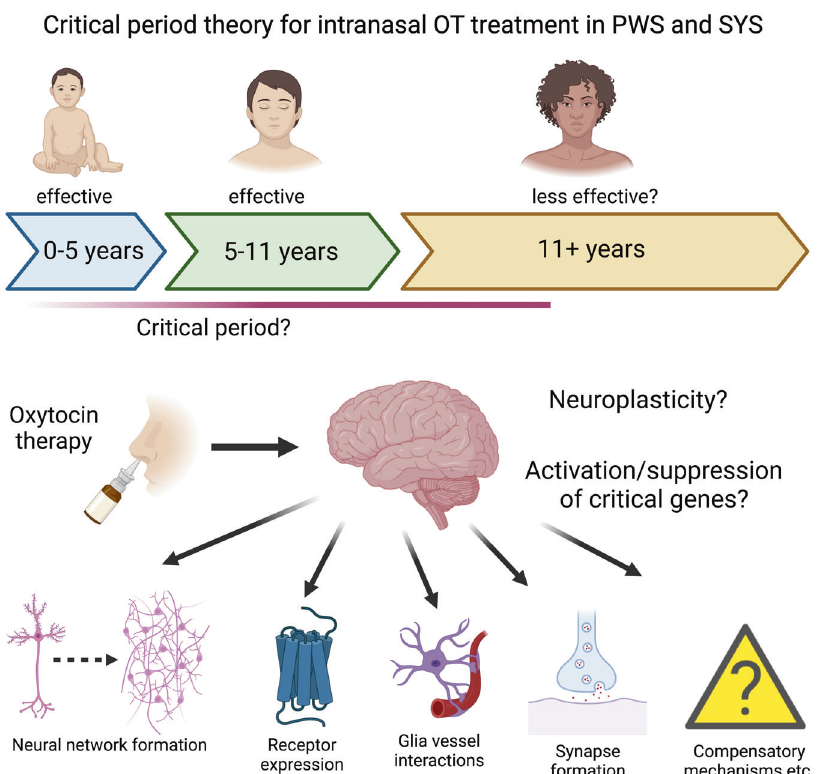
Fig. 4 Critical period theory for intranasal OT treatment in PWS and SYS. Intranasal OT treatment for PWS proved to be most effective in children aged 5 – 11 years. Thus, it is tempting to speculate about the existence of a critical period, in which brains of PWS patients are most receptive for OTergic therapy and the neural circuit can be re-wired and compensate for the dysfunctional MAGEL2 protein. Reasons for the enhanced ef fi cacy of OTergic treatment could include neuroplasticity, activation or suppression of key genes, as well as the formation of new neural networks, receptor expression, synapse formation, and other